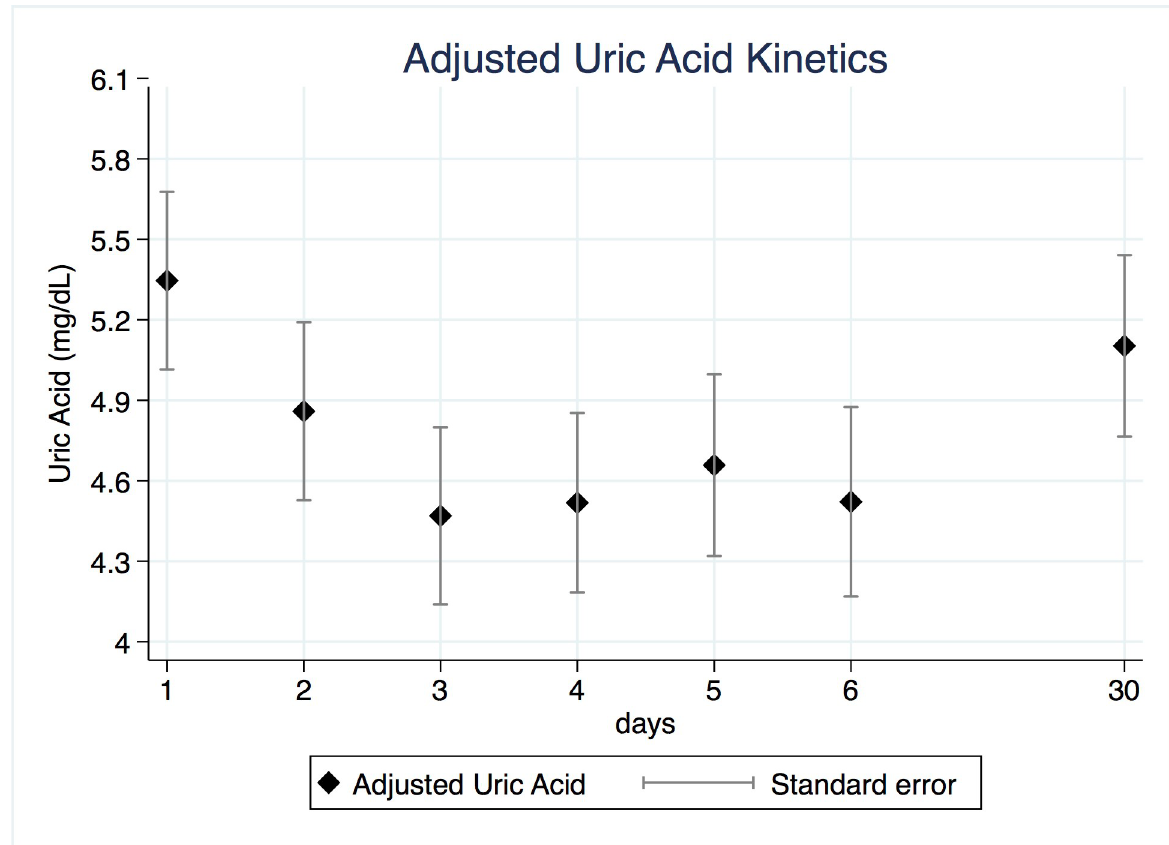
Fig 1. Adjusted uric acid kinetics. Adjusted values of uric acid during the first week after symptoms onset and 30 days later. Diamonds represent uric acid adjusted by sex, age and DWI volume at diagnosis, and data dispersion is presented as standard error.